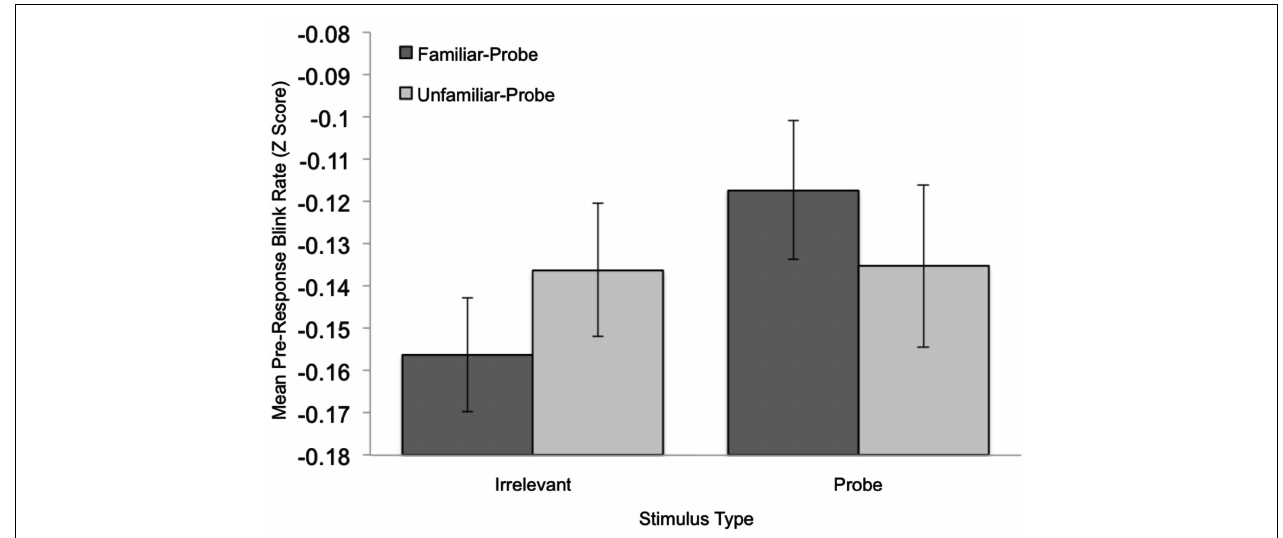
FIGURE 3 | Mean standardized pre-response ( − 100 to − 400ms relative to the response) blink-rate data plotted as a function of StimulusType and Condition. Error bars indicate standard error of the